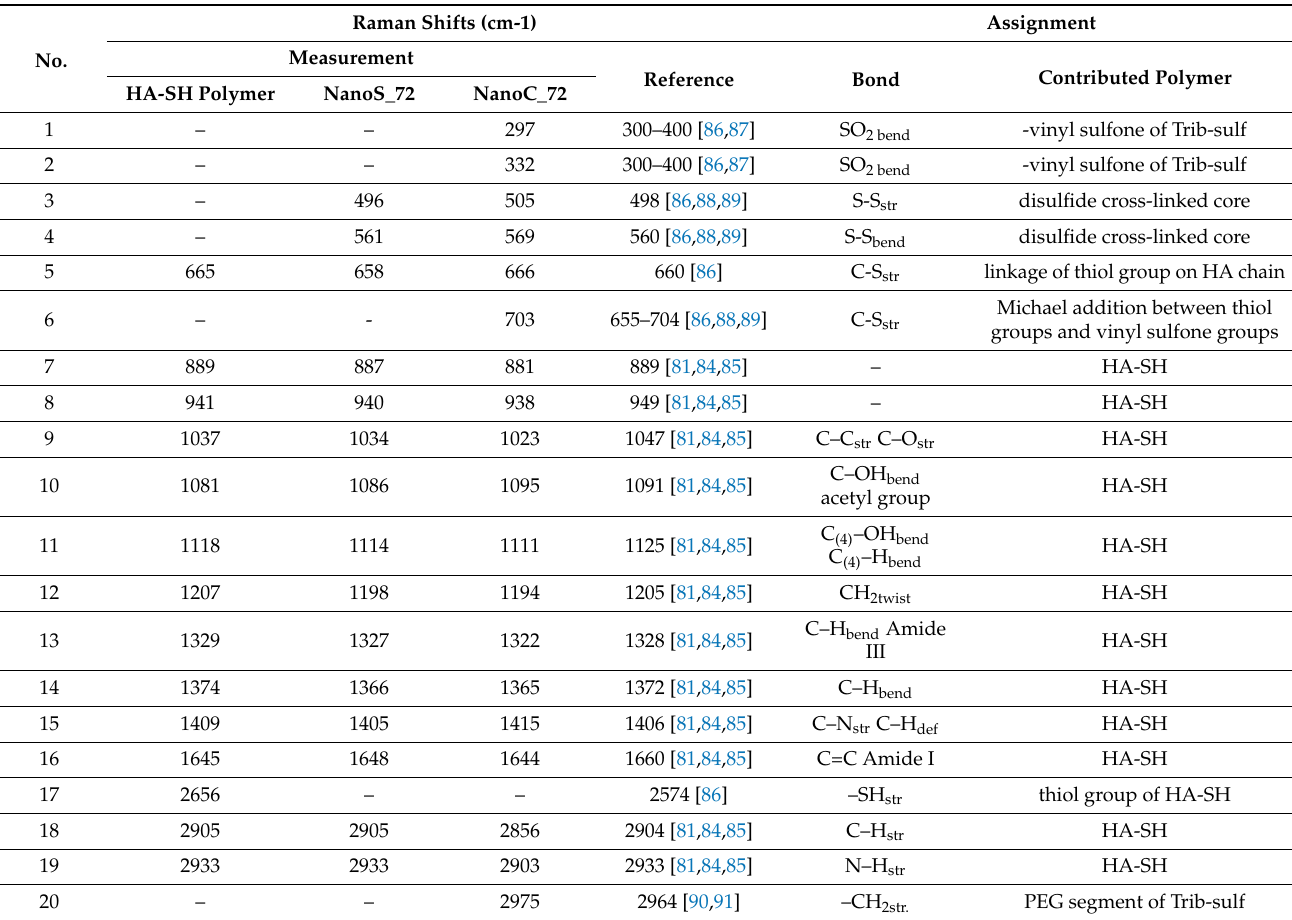
Table 4. Assignment of Raman bands of observed in HA-SH polymer, NanoS_72 and NanoC_72.